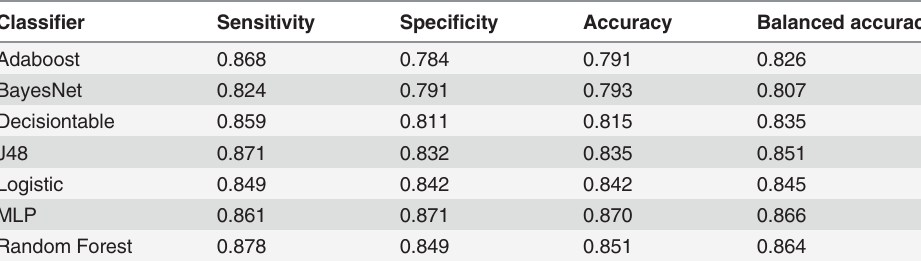
Table 5. Comparison with several machine learning methods.